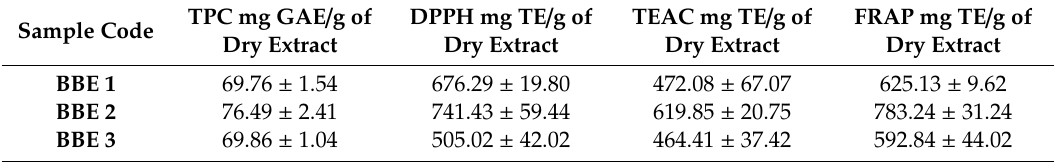
Table 5. Antioxidant activity of optimized beech bark